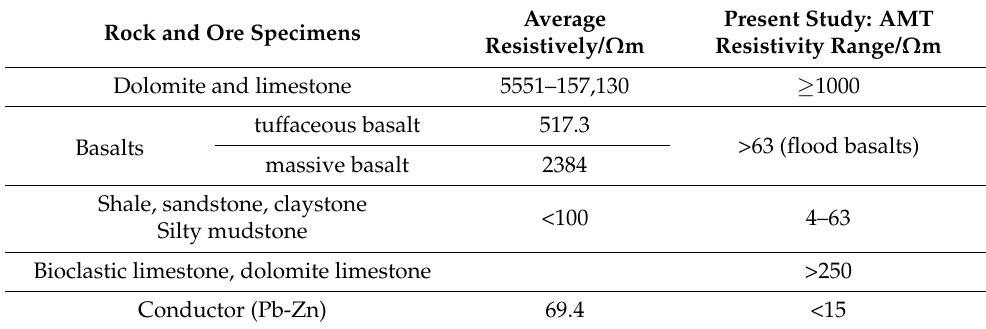
Figure 10. AMT resistivity cross-section across the Zhugongtang deposit showing inferred lithologic units and major faults. Table 1. Rock and ore specimens resistivity comparison with AMT data in the study area.